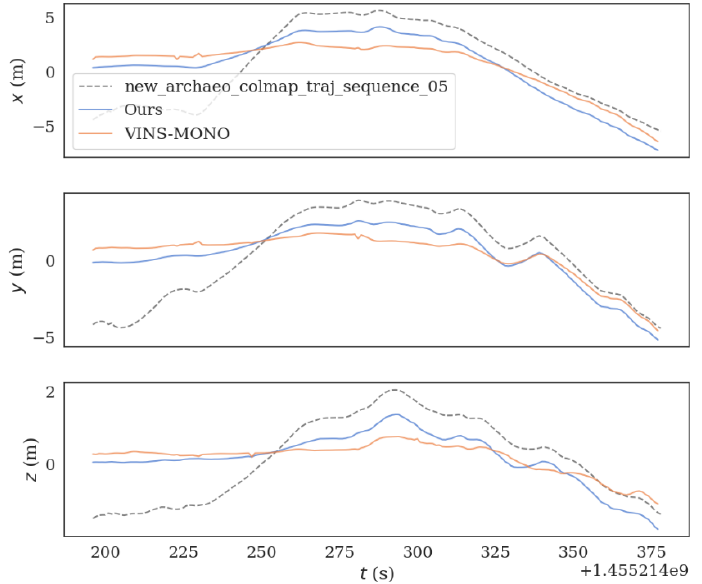
Figure 12. The figure shows the translation error comparison between the original algorithm and the improved algorithm in sequence_05.bag datasets.